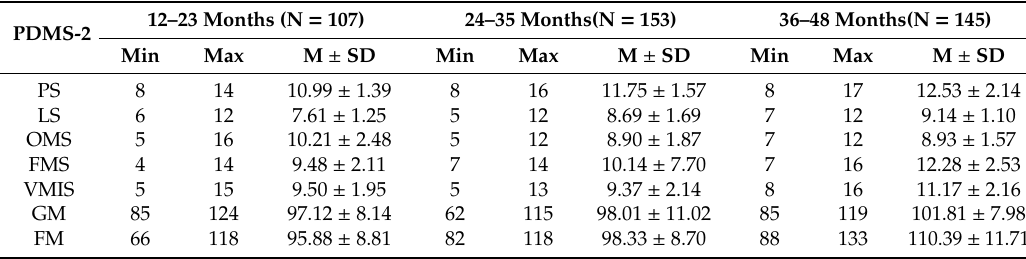
Table 2. Descriptive statistics for the PDMS-2 results in each age-range